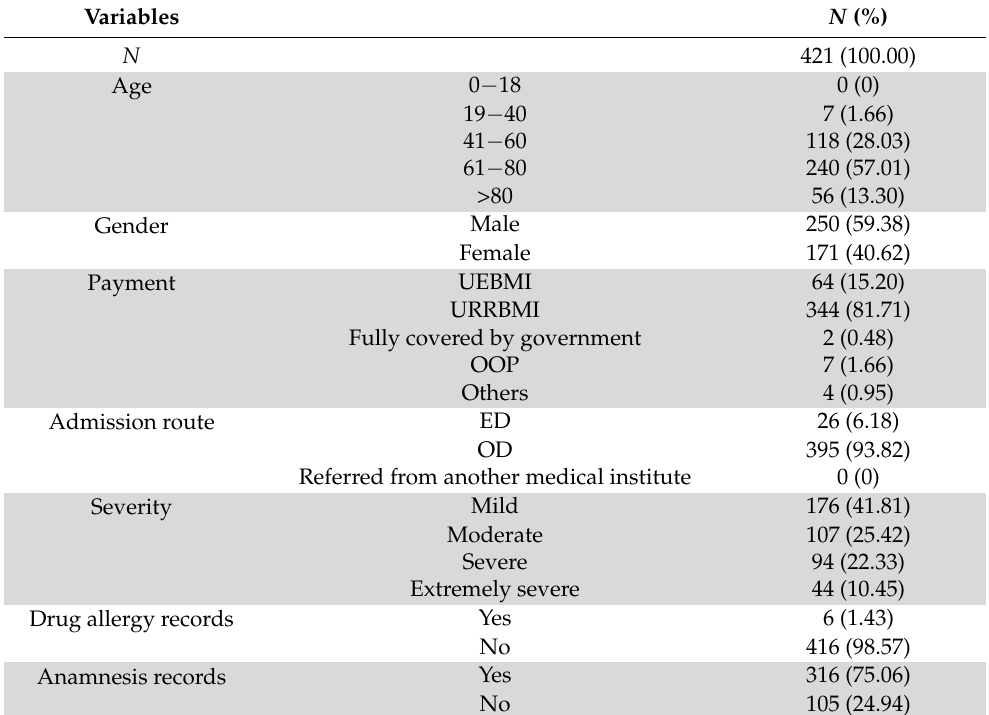
Table 2. Characteristics of included stroke patients ( N =